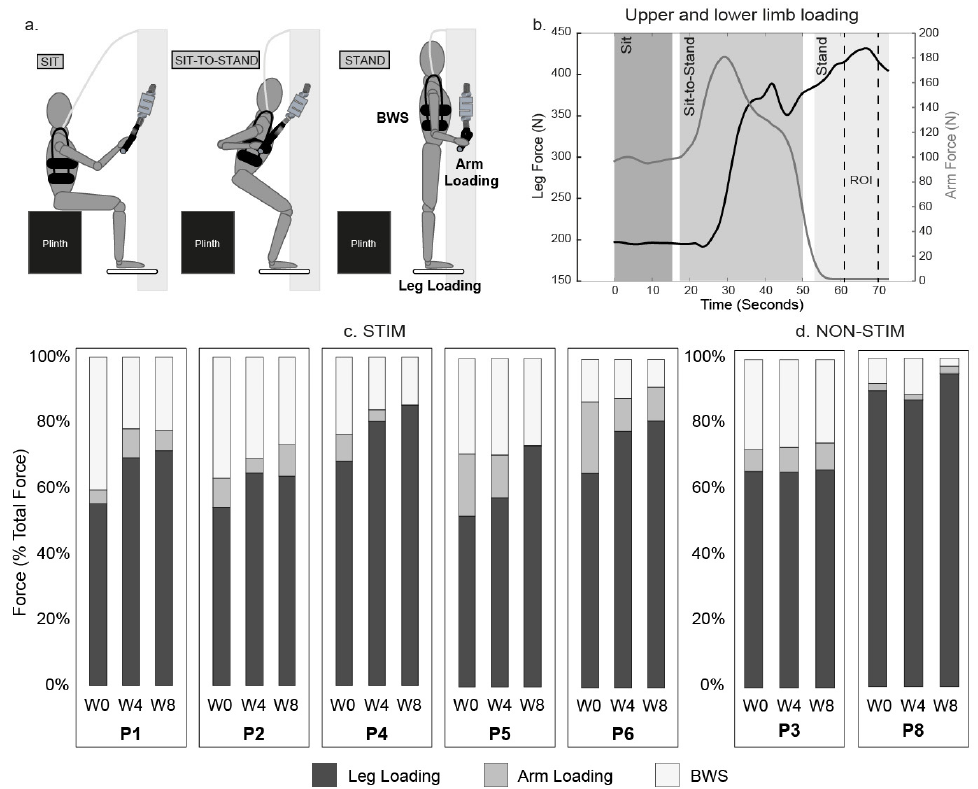
Figure 3. Maximum loading through the lower and upper limbs during standing. Experimental set up ( a ) and example plot of measured leg force (black) and arm force (grey) from one participant with dashed lines indicating an isolated region of interest (ROI) used to quantify force as described in 2.6 ( b ). The weekly changes in distribution of forces (measured from the ROI) are shown in ( c , d ). Loading though lower limbs (black), upper limbs (grey) and manually recorded bodyweight support (white) at week 0, 4 and 8 of the intervention, for all participants.